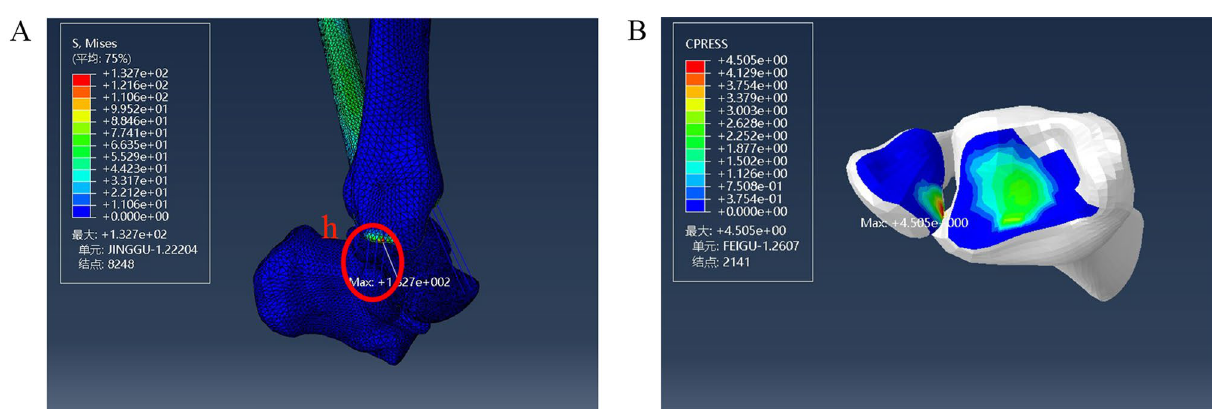
Figure 9. Distribution of stress during injury of the posterior tibiofibular ligament in a stage III supination- external rotation ankle injury. ( A ) Maximum stress view. ( B ) Maximum contact stress view. Units of measurement: Mpa. h: The posterior talofibular ligament.